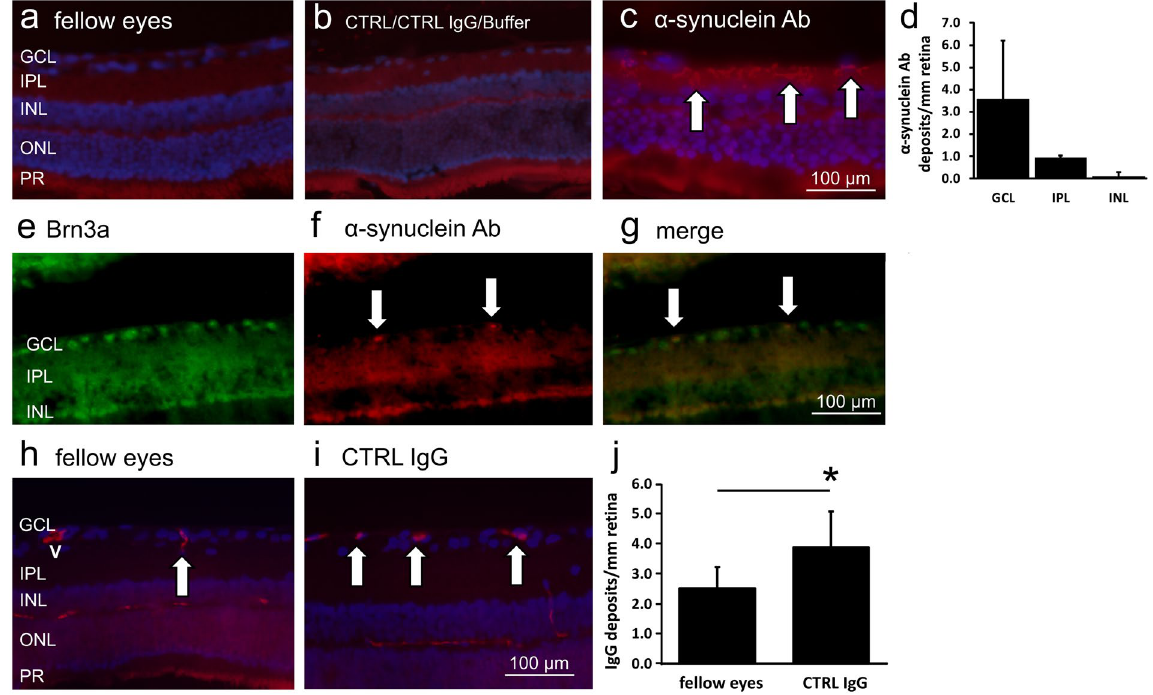
Figure 5. Localization of the α -synuclein antibody in retinal cross sections. The localization of the previously injected α -synuclein Ab was visualized with immunohistochemistry on retinal cross sections using a goat anti-rabbit IgG (H + L) Cy3 secondary Ab. ( a ) The fellow eye revealed weak unspecific background staining. ( b ) CTRL, CTRL IgG and Buffer group showed weak unspecific background staining. ( c ) Specific staining of α -synuclein Ab in the α -synuclein Ab group was observed in the innermost layers of the retina (indicated by arrows). ( d ) Analysis of α -synuclein Ab deposits per mm retinal layer. ( e–g ) A colocalization of Brn3a-positive retinal ganglion cells and α -synuclein Ab could be shown. ( h–j ) IgG deposits were visualized in retinal cross sections of fellow eyes and CTRL IgG-injected eyes (indicated by arrows, a blood vessel is marked with v). Abbreviations: GCL: ganglion cell layer, IPL: inner plexiform layer, INL: inner nuclear layer, ONL: outer nuclear layer, PR: